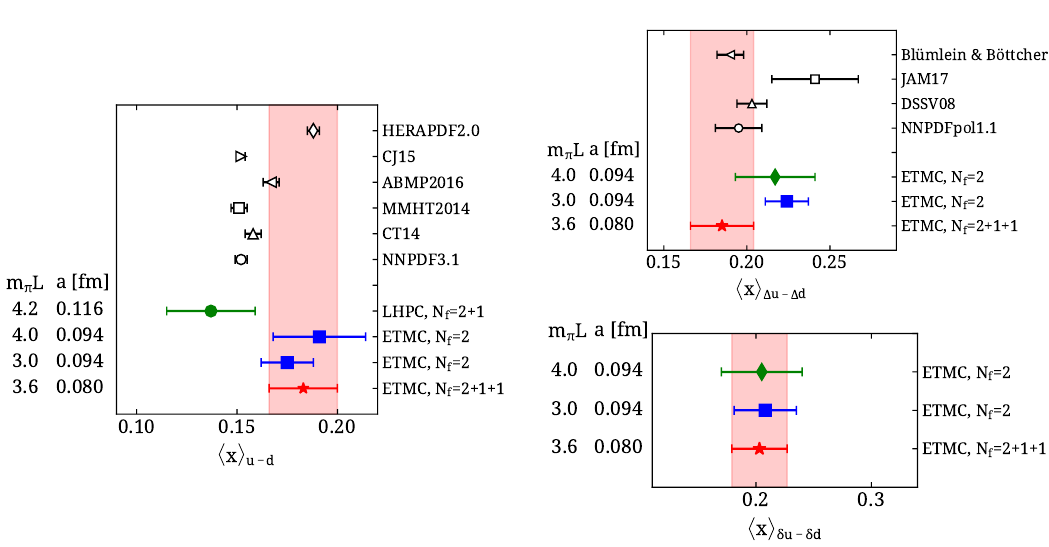
Figure 8: A comparison of recent lattice QCD and phenomenological results on the momentum fraction 〈 x 〉 (left), on the helicity moment 〈 x 〉 ∆ u − d and the transversity 〈 x 〉 δ (lower right). The error band is the one associate with u − δ d the analysis of the twisted mass ensemble